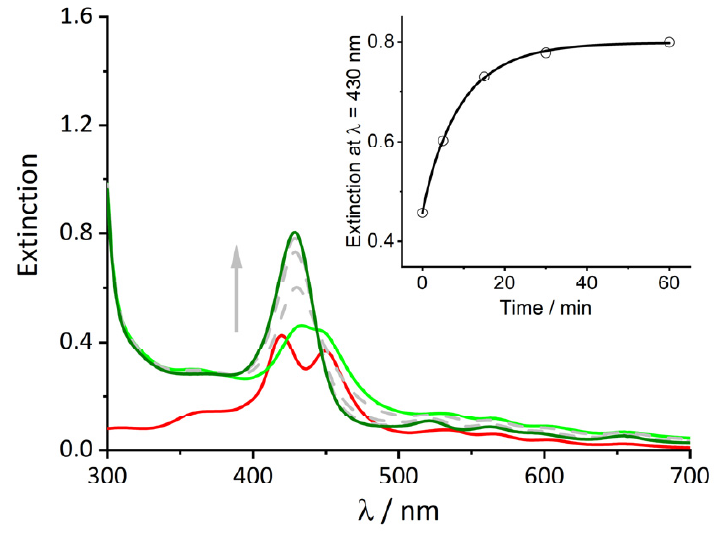
Figure 2. UV/Vis spectra of t-H 2 Pagg aggregates (red curve) after addition of HSA at t = 0 s (light green curve) and at t = 60 min (dark green curve). Grey spectra and arrow indicate over time evolution. Inset: change over time of the extinction value at λ = 430 nm relative to the formation of the t-H 2 Pagg/HSA adduct. Solid line represents the fit obtained with Equation (2) ( k = 0.1083 ± 0.0056 s − 1 , n = 0.94 ± 0.06). Experimental conditions: [t-H 2 Pagg] = 5 µ M, [NaCl] = 100 mM, [HSA] = 100 µ M, phosphate buffer 1 mM, pH = 7.4, T = 298 K.